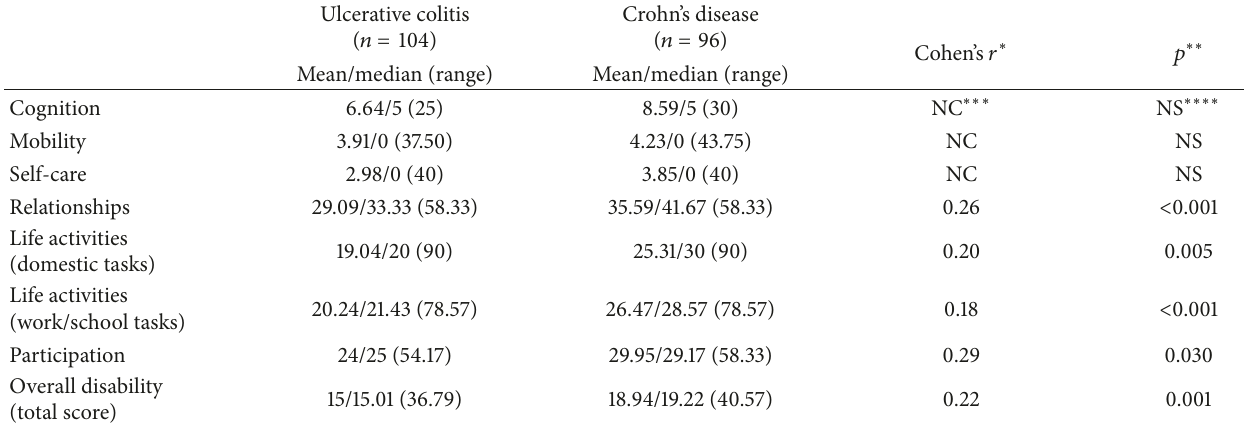
Table 2: Comparison of the total and dimensional summary scores for WHODAS 2.0 between the two patients’